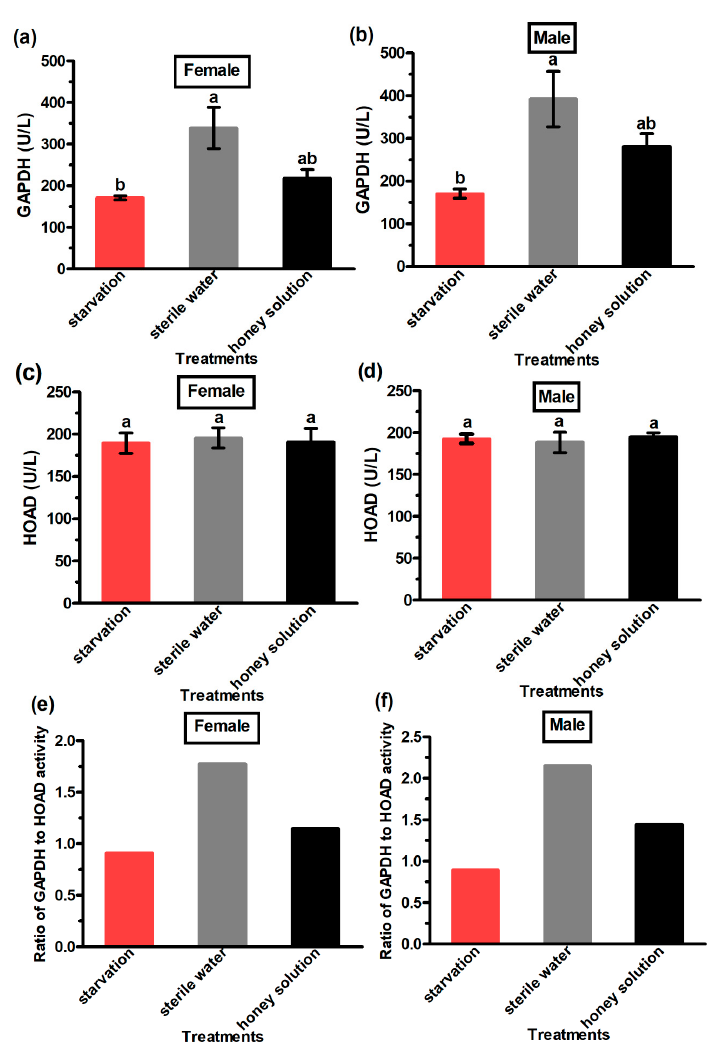
Figure 6. The activity (U/L) of GAPDH ( a , b ) and HOAD enzymes ( c , d ) and the ratio of GAPDH and HOAD activity ( e , f ) of Grapholita molesta female and male moths under different feeding treatments. The standard error is represented by the error bars, and different letters denote significant differences among the treatments (ANOVA: HSD test, p < 0.05) in graphs ( a – d